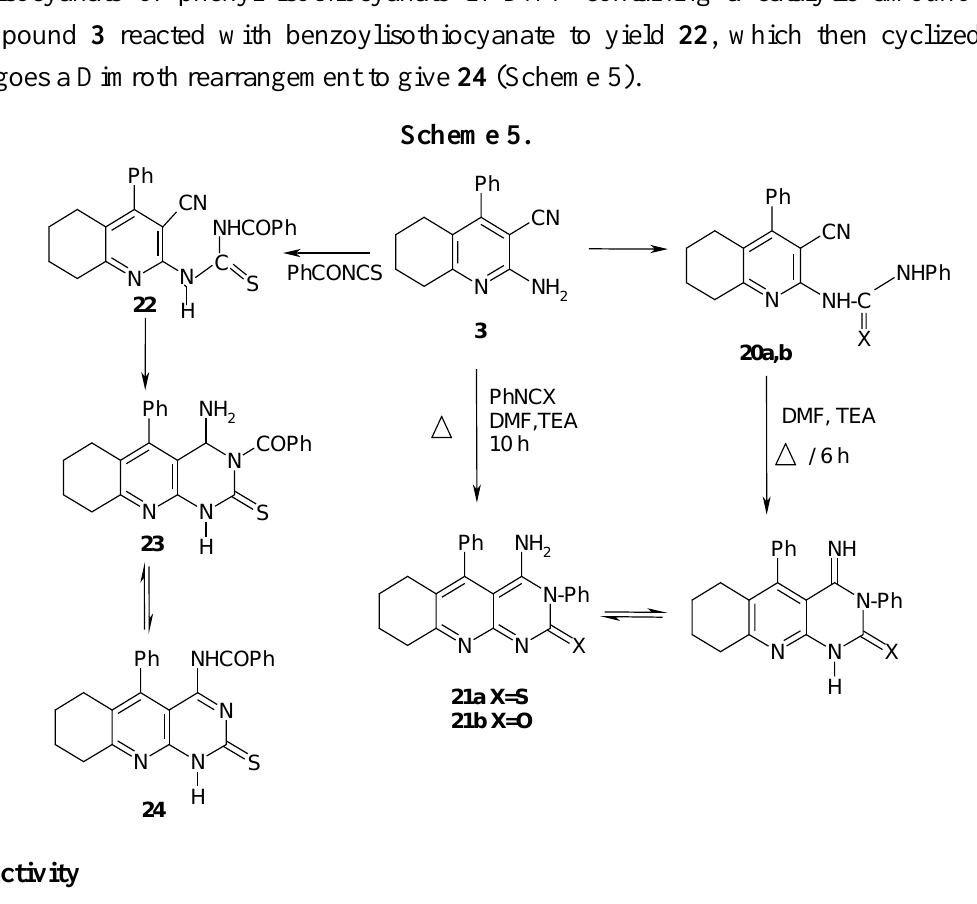
Table 3. The antimicrobial activity of select derivatives at 1000 ppm concentration.